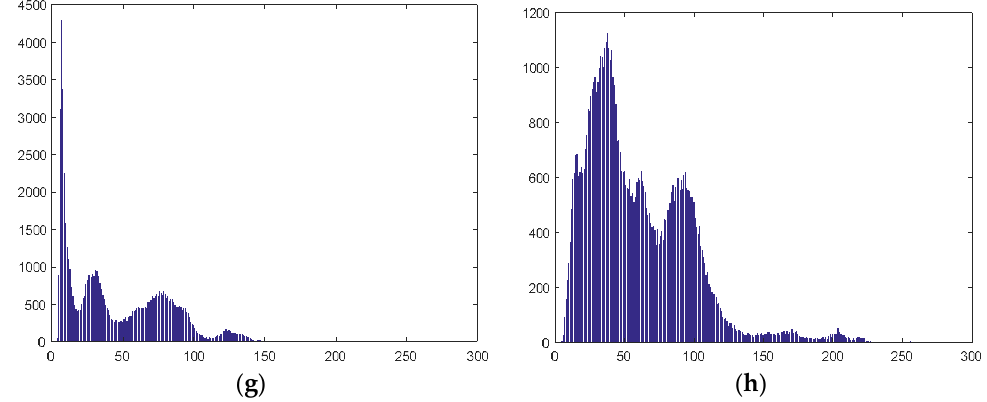
Figure 7. Histograms of the R component of the night-time images in different conditions. ( a , e ) Grape clusters near the light-source center; ( b , f ) grape clusters near light-source center and on the edge of the image; ( c , g ) grape clusters out of the light-source center and on the edge of the image; ( d , h ) no grape cluster.